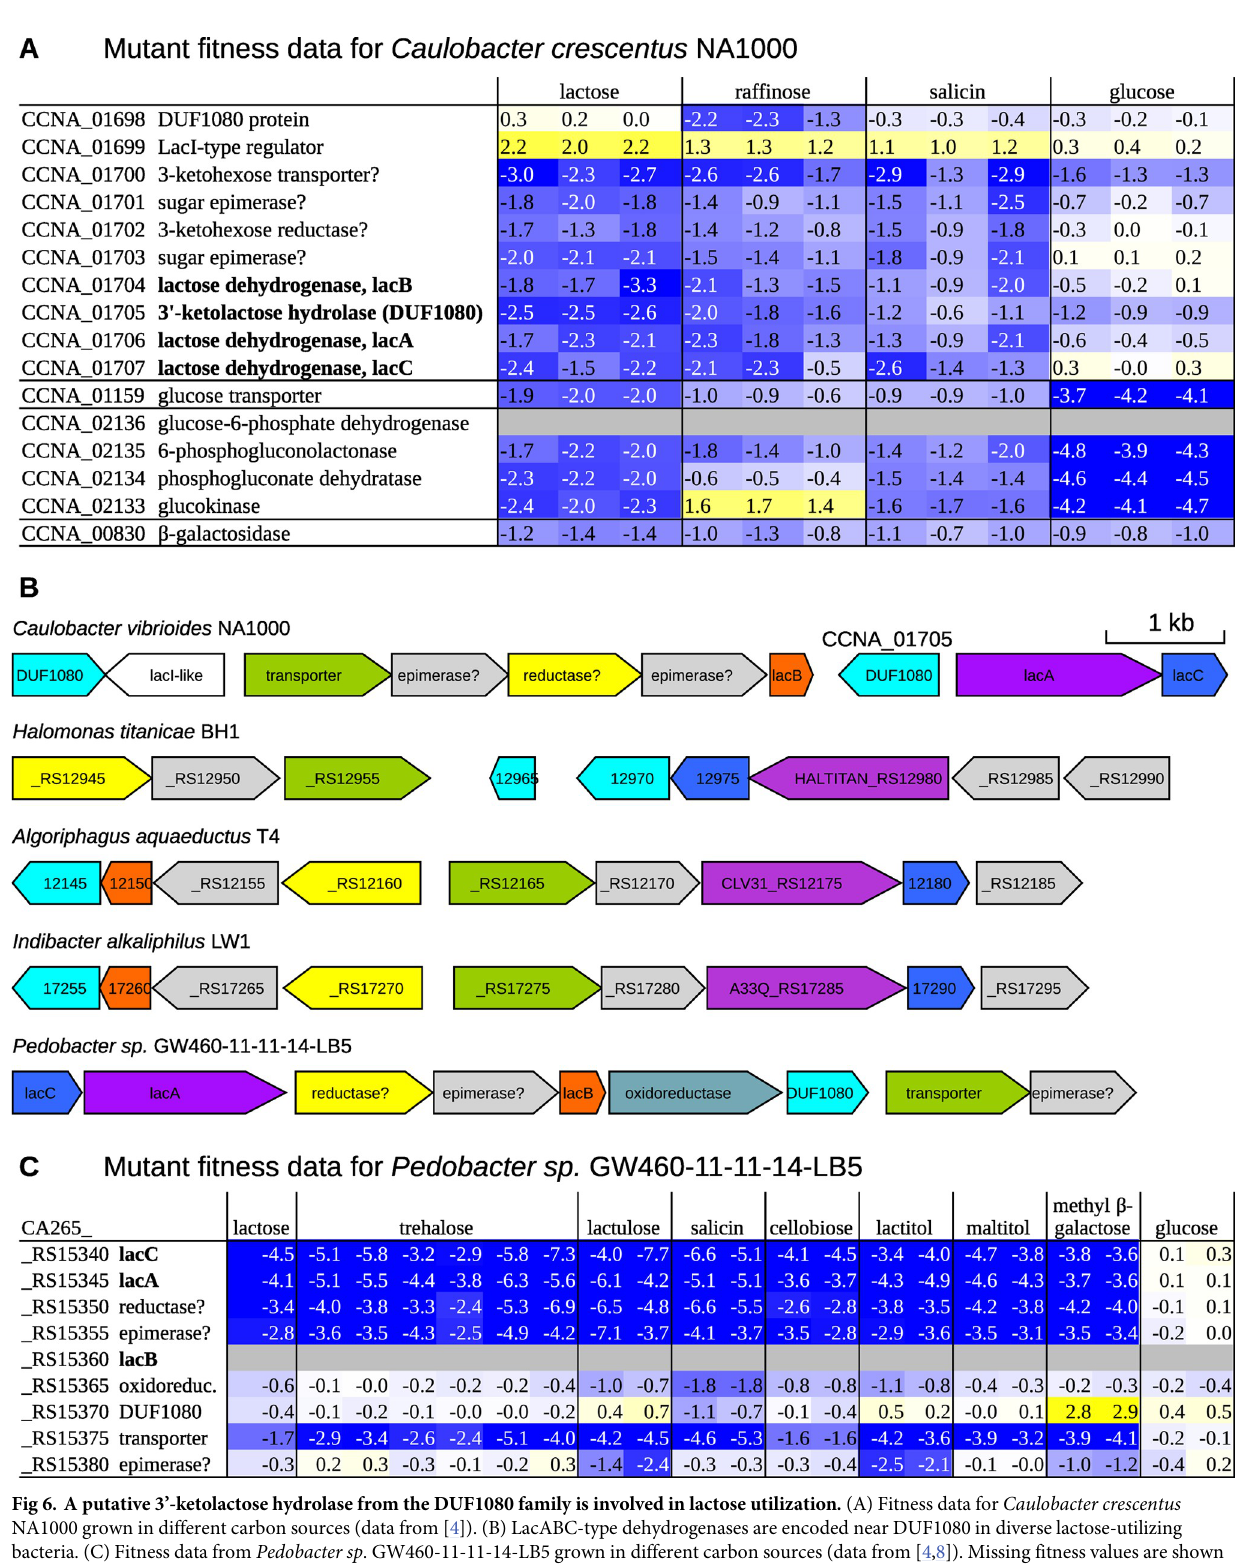
PLOS Genetics | https://doi.org/10.1371/journal.pgen.1010156 April 13, 2022 12 /